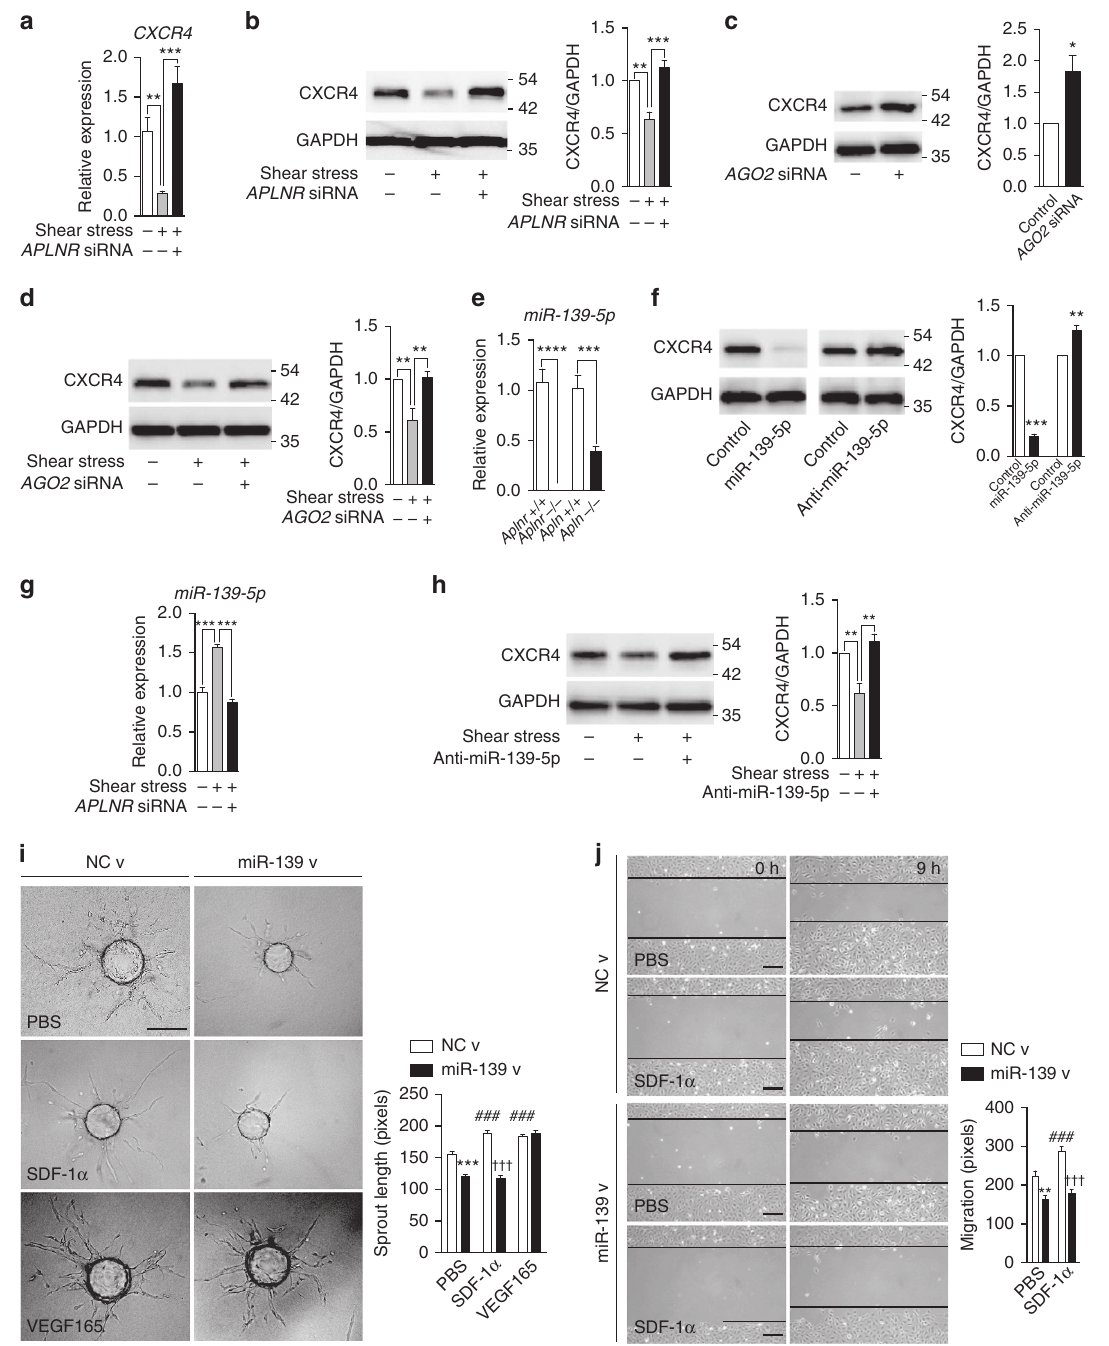
Figure 3 | APLNR regulates CXCR4 expression through miR-139-5p. ( a , b ) CXCR4 expression in response to shear stress exposure in HUVECs, with or without concurrent APLNR knockdown. mRNA ( a ) and protein levels ( b ) are shown. ( c ) CXCR4 expression in response to AGO2 knockdown. ( d ) CXCR4 expression in response to shear stress exposure in HUVECs, with or without concurrent AGO2 knockdown. ( e ) Determination of miR-139-5p levels in FACS sorted ECs from P5 retinas of Aplnr (cid:2) / (cid:2) , Apln (cid:2) / (cid:2) mice and respective littermates. n ¼ 3 retinas per genotype. ( f ) CXCR4 expression in HUVECs overexpressing miR-139-5p mimic or non-targeting control anti-miR. ( g ) Expression levels of miR-139-5p in response to shear stress, with or without concurrent APLNR knockdown. ( h ) CXCR4 expression in HUVECs in response to shear stress exposure, with or without concurrent miR-139-5p inhibition via anti-miR. ( i ) Sprouting assay using HUVEC covered beads transduced with miR-139-5p or control lentivirus in response to SDF-1 a or VEGF 165. Scale bar, 175 m m. ( j ) Migration assay of HUVECs transduced with miR-139-5p or control lentivirus in response to SDF-1 a . Scale bar, 200 m m. * P o 0.05, ** P r 0.01, *** P r 0.001, ### P r 0.001 against NC v/PBS, www P r 0.001 against NC v/SDF-1 a , t -test. Error bars represent s.e.m. n ¼ 3 experiments per